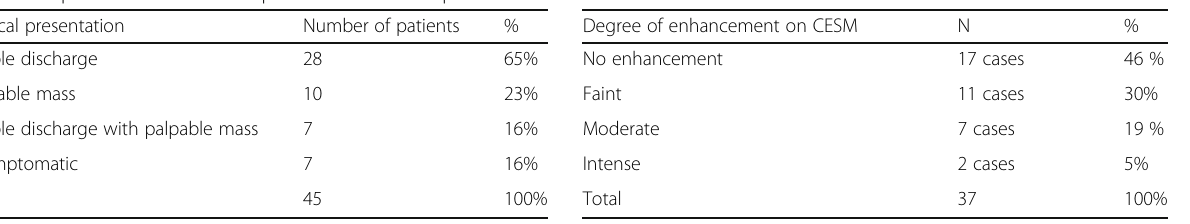
Table 3 Represented analysis of papilloma cases regarding